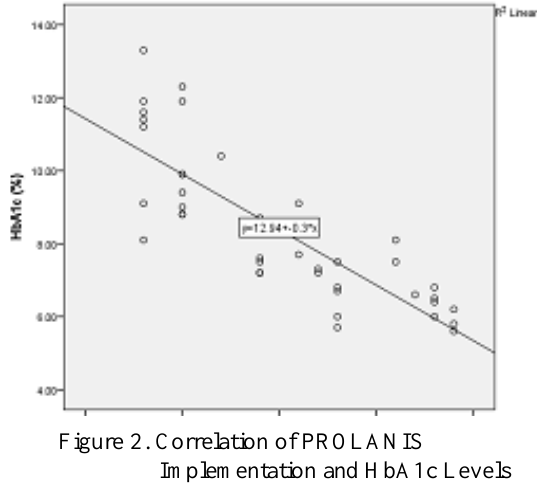
Figure 2. Correlation of PROLANIS Implementation and HbA1c